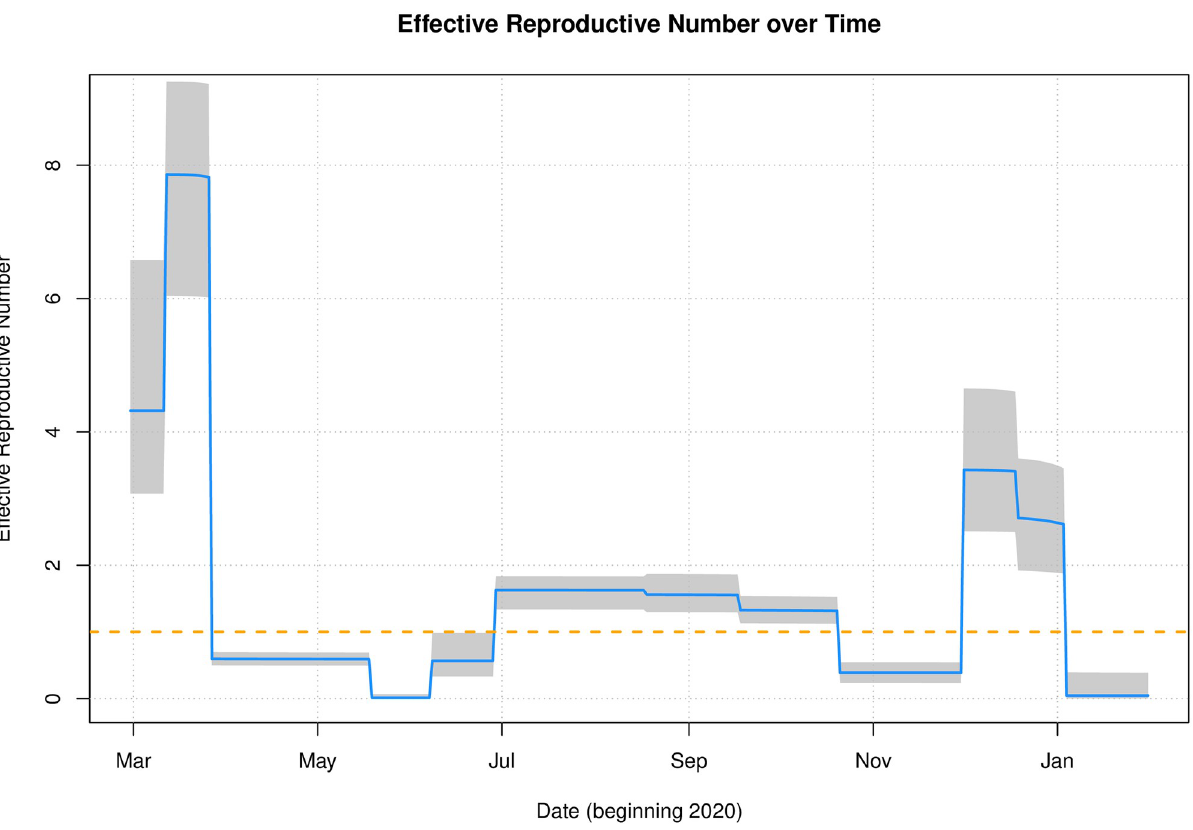
Fig 7. The effective reproduction number R ( t ). The solid line was calculated from the best fit parameters, and the uncertainty intervals were drawn by computing R ( t ) for each bootstrap replicate and selecting the 2.5% and 97.5% quantiles at each time point.